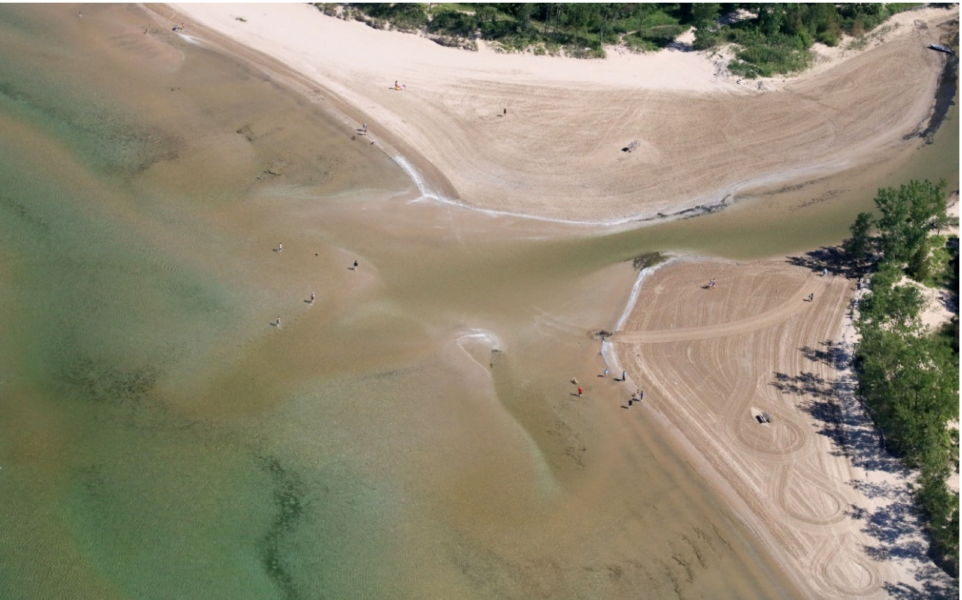
Figure 6. Accretion at Outlet Beach and Outlet River mouth (Aerial image by: John A. Brebner, 2018 © 2012–2018, Friends of Sandbanks